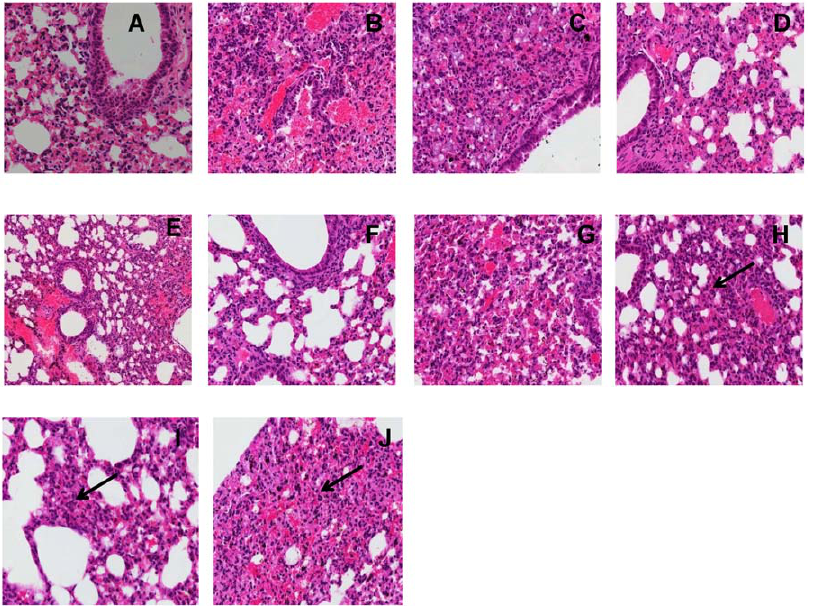
Figure 4. Histopathology in sections of lungs harvested from mice 3 dpi with each of the APMV serotypes. Mice were mock-infected (panel A) or infected with APMV-1 (panel B), APMV-2 (panel C), APMV-3 (panel D),APMV-4(panel E), APMV-5 (panel F), APMV-6 (panel G),APMV-7(panel H),APMV- 8 (panel I), and APMV-9 9panel J).Sections were stained with hematoxylin and eosin (magnification, 6 400). Inmock-infected mice, the bronchiole is lined by a single layer of epithelial cells, alveoli are filled with air (although partially collapsed) and lined by flattened type I pneumocytes and there is mild acute alveolar hemorrhage likely secondary to CO2 euthanasia. APMV-5 infected mice had no detectable lesions and were indistinguishable from mock-infected mice. In APMV-1 and -2 infected mice, severe subacute diffuse necrotizing bronchointerstitial pneumonia was observed (panels B and C). Further, alveolar spaces and septae arefilled with hemorrhage, fibrin, edema, and mixedinflammatory cells (neutrophils,macrophages, lymphocytes, plasma cells), as well as necrotic cellular debris (panels B and C). In APMV-1 infected mice, alveolar spaces/interstitium are more severely affected than are the airways (panel B). Further, bronchiolar epithelial cells are hypertrophied with karyomegally and occasional individual cell necrosis/apoptosis was also observed (panel B). In APMV-7 and -9 infected mice, there is type II pneumocyte hypertrophy as well as endothelial cell hypertrophy (black arrows in panels H and J). In APMV-8 infected mice, there are neutrophils in expanded alveolar septae (black arrow in panel I). However, mild bronchointerstitial pneumonia was observed in mice infected with some APMVs with different degrees of bronchiole damage (panels D, E and G to J).